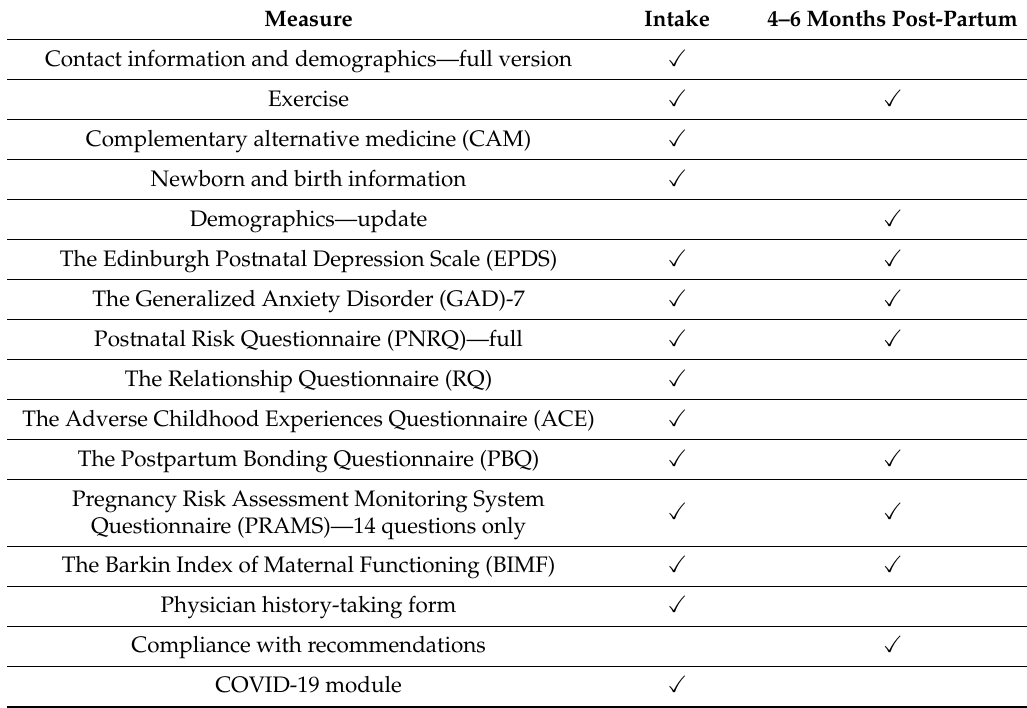
Table 3. Timeline of protocol 2 (first seen after